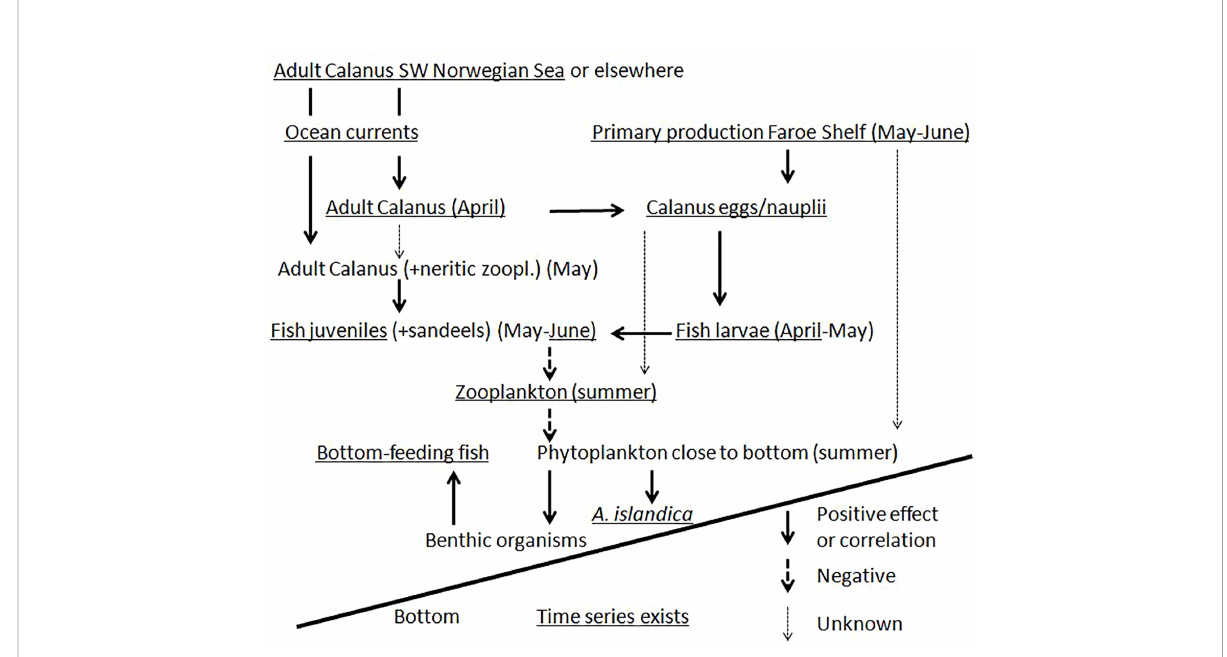
FIGURE 9 Simpli fi ed schematic presentation of ecological processes on the Faroe Shelf. Note that this is not a complete description of all ecological linkages but is meant to clarify the ecological processes discussed in the current